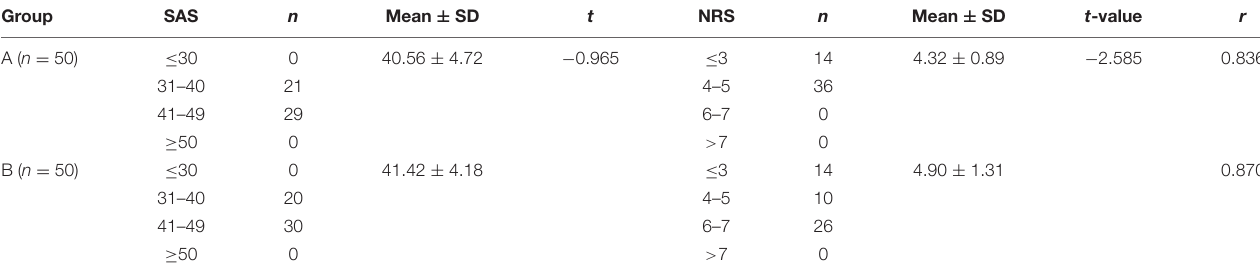
TABLE 4 | The preoperative anxiety and postoperative pain of the two groups of patients.